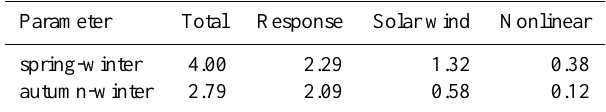
Table 2. Components of seasonal difference in